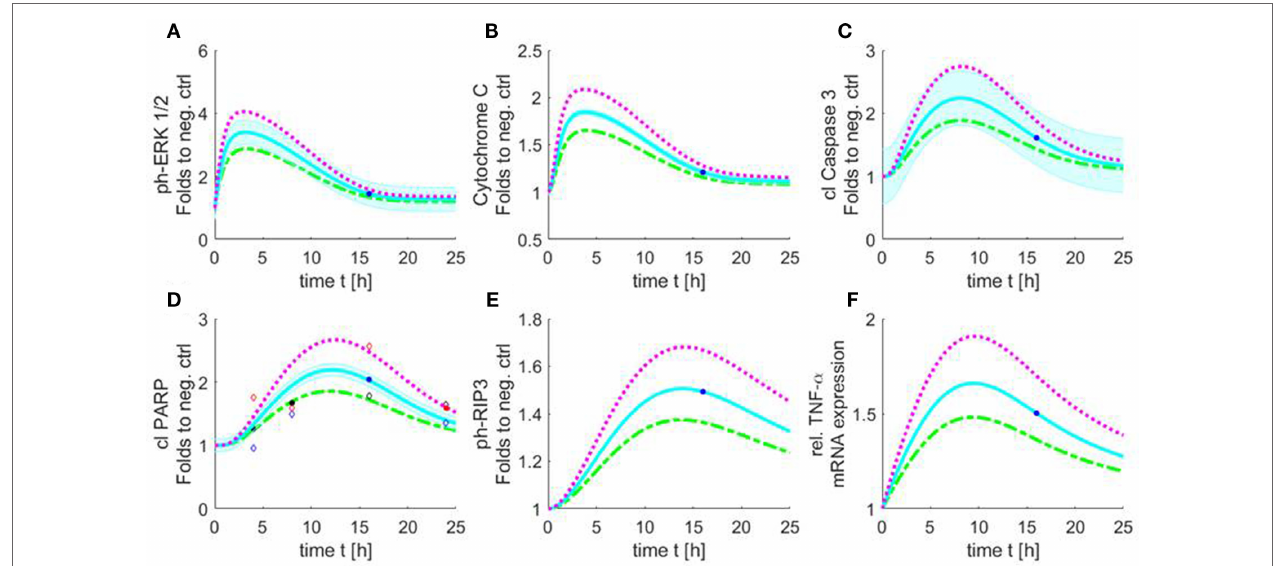
FIGURE 9 | Simulated time course of all involved components of the apoptosis/necroptosis signal pathway induced by HS. Simulated time course of the components involved in intrinsic apoptosis and necroptosis signaling pathways for cardiomyocytes exposed to three different HS concentrations [5 (green), 10 (blue), and 20 (purple) μ g/ml of HS]. The blue background represents the standard error of the measured data. The model was simulated based on relative cleaved PARP values. The filled points in graphs represent data used for training and the unfilled for validation. Simulated time course for relative protein expression of (A) phosphorylation of ERK 1/2, (B) cytochrome C, (C) cleaved caspase 3, (D) cleaved PARP, and (E) phosphorylation of RIP3 is shown. (F) Simulated data of relative TNF- α mRNA expression. HS, heparan sulfate; ph-ERK, phospho-extracellular signal-regulated kinase; PARP, poly-(ADP-ribose) polymerase; RIP, receptor-interacting protein; TNF- α , tumor necrosis factor alpha.